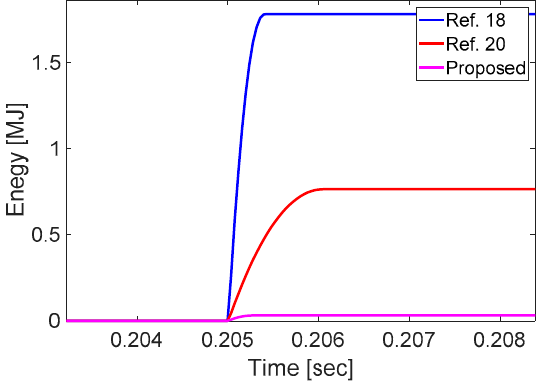
Figure 18. Power absorbed by main MOA under di ff erent solutions.